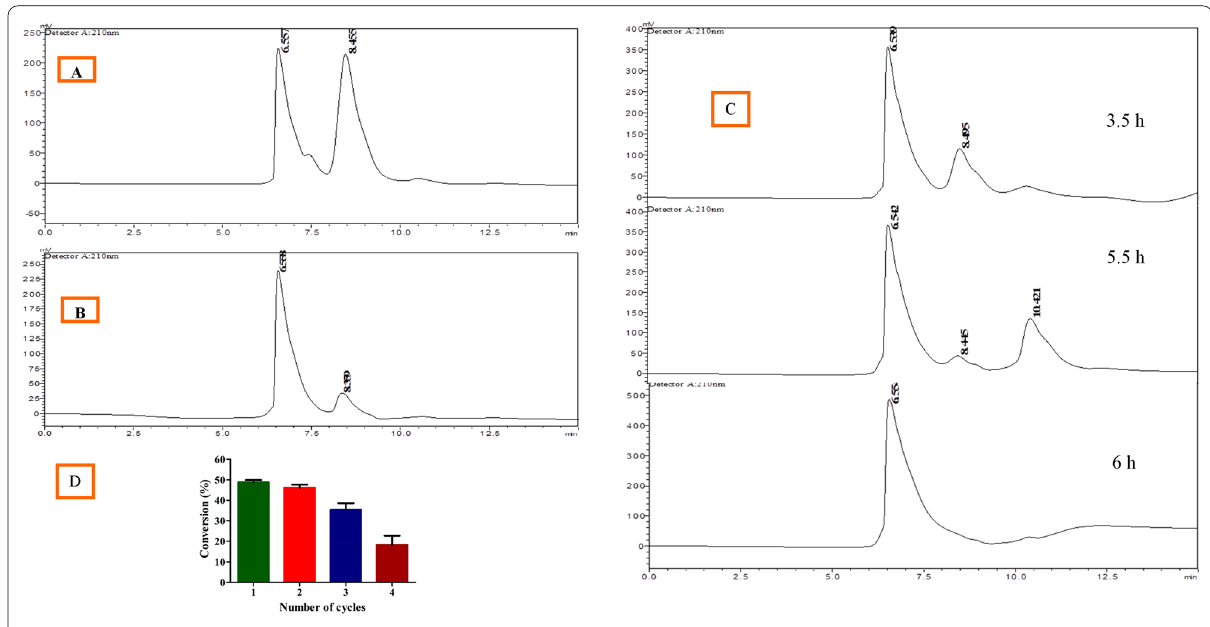
Fig. 6 A FTIR spectra overlay of free enzyme, immobilized enzyme [TA@Cu3(PO4)2NF], and immobilized matrix. B CD spectra overlay of free enzyme, TA@Cu 3 (PO 4 ) 2 NF, sonicated enzyme, and immobilized matrix. C The overlay of fluorescence spectra: free enzyme and TA@Cu 3 (PO 4 ) 2 NF. D reusability study of TA@Cu 3 (PO 4 ) 2 NF